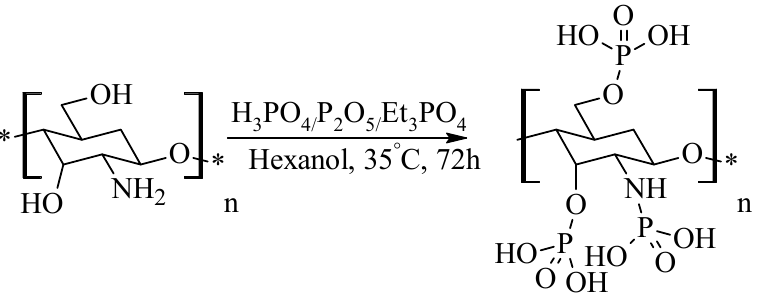
Figure 8. Synthesis method of phosphorylated chitosan.